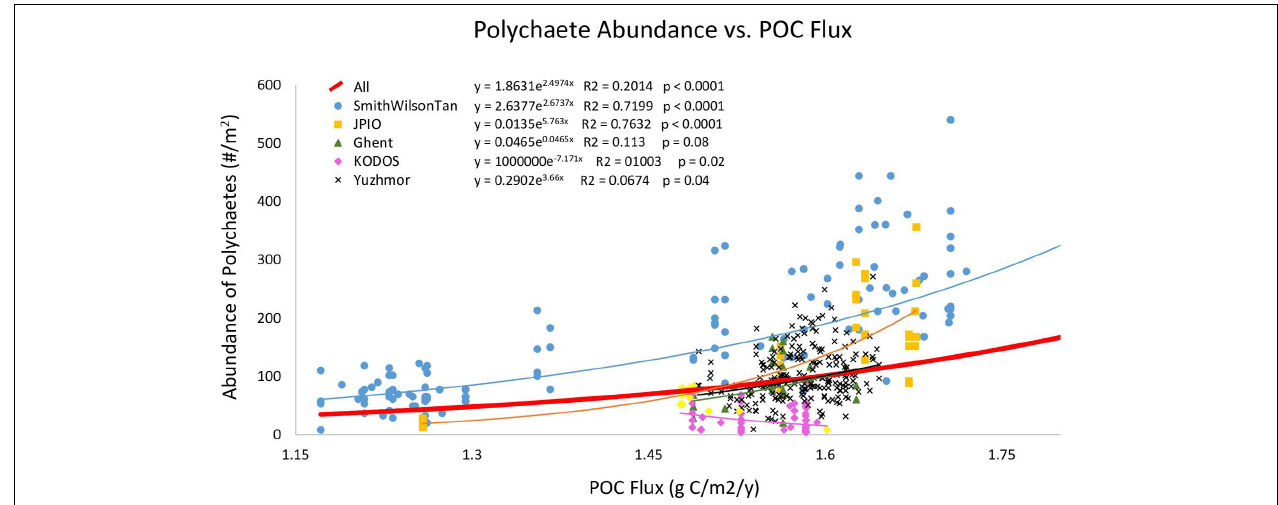
FIGURE 2 | Polychaete abundance in individual box cores versus Lutz POC flux. Curves are Type II regressions conducted in R, with regression equations, R 2 values, and p levels of regressions indicated. The bold red line is the exponential regression for all sampling programs combined. Regression lines for data sets match the colors of their symbols in the upper left. The pink regression line represents all KODOS data, while yellow diamonds represent KODOS samples collected in 2019. This figure does not show data points for Smith-0, Smith-2, or Smith-5 (which are included in the regressions/curves) as they have much larger POC fluxes and abundances than all other sites making observations of trends for other studies